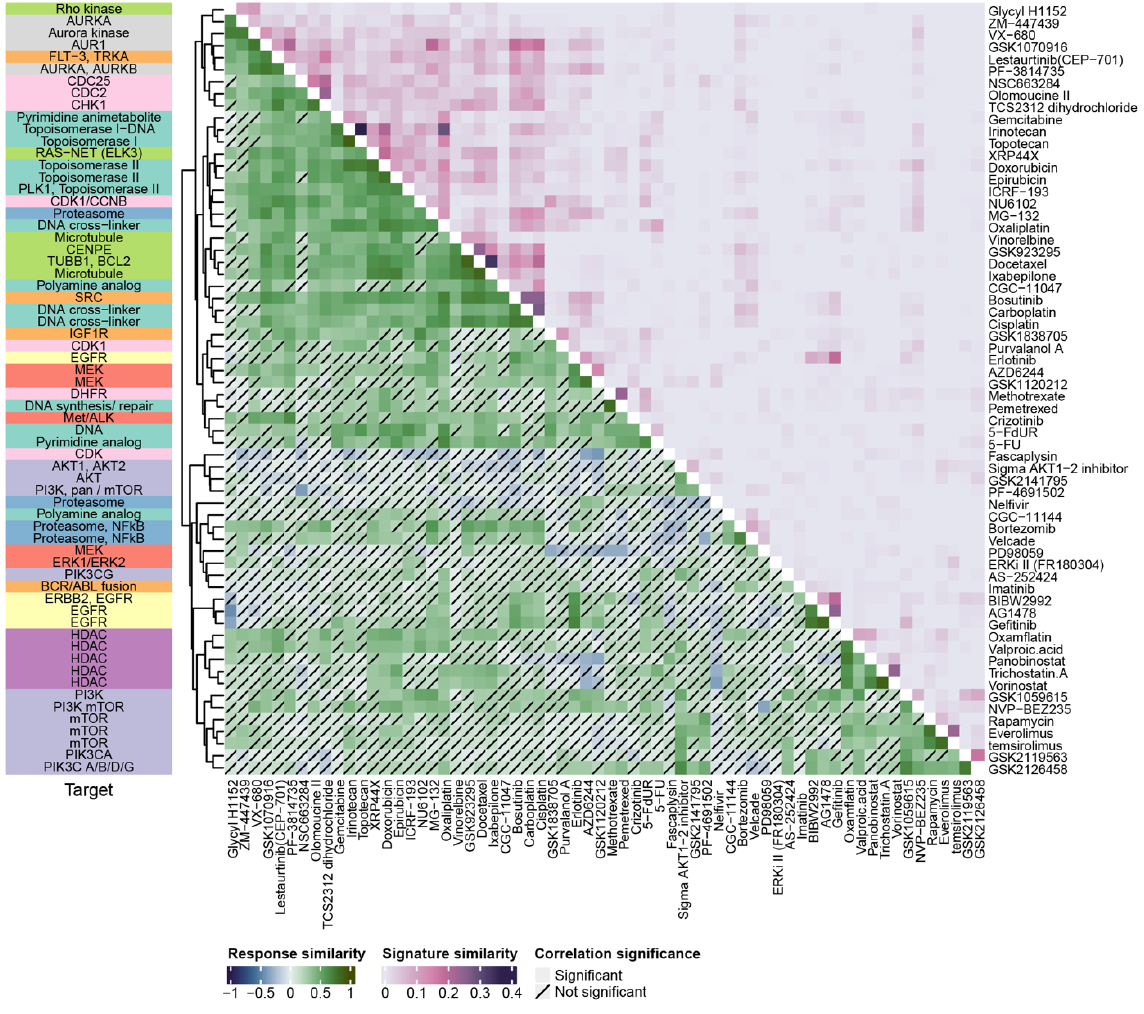
Figure 2. Drug response similarity is retained in drug efficacy signatures. Drug response similarities in the GRAY dataset measured using the Spearman correlation coefficient are shown on the lower triangle of the plot with non-significant correlations ( p -value > 0.05) crossed out. The upper triangle of the plot represents signature similarities computed using the Jaccard index. Drug classes are labeled on the y -axis of the heatmap.